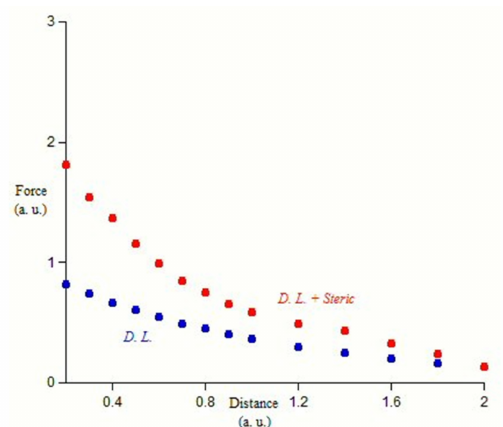
Figure 7. Overlap of purely electrostatic terms, in light blue, with steric stabilization, in red, forces at short distances: forces are in arbitrary units. It is evident, therefore, that the elimination of steric terms largely reduces the system